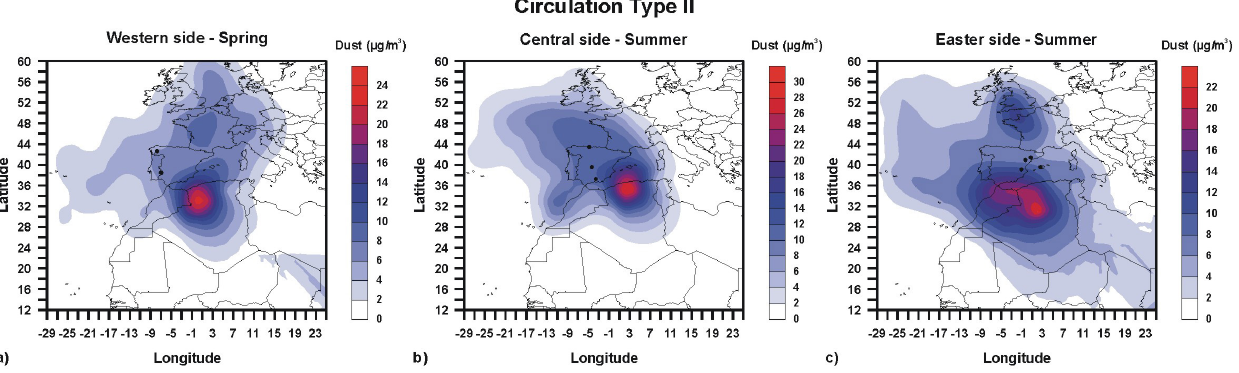
Figure 11. RCFs for African dust contributions (µgm − 3 ) during ADO generated by circulation type II over the western, central and eastern sides of the area of study in spring and